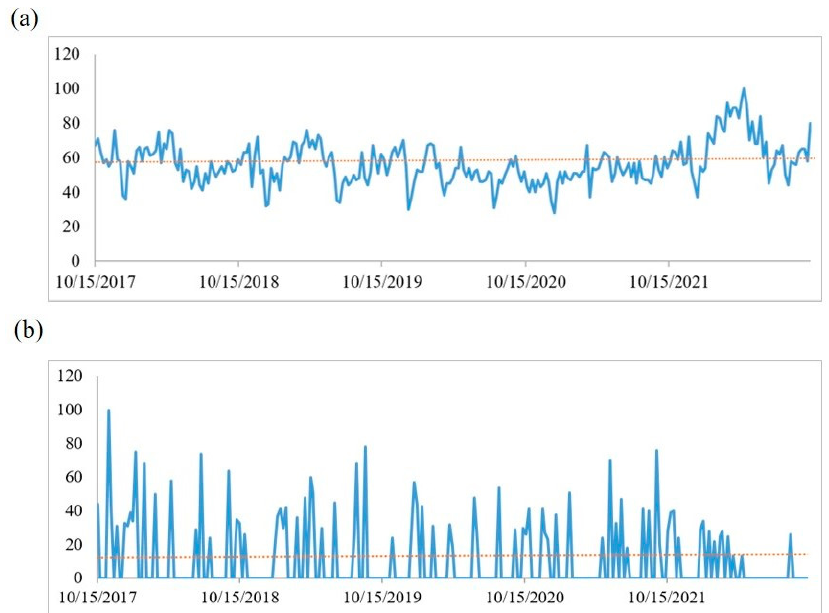
Figure 8. Time series of solar photovoltaic count in ( a ) worldwide and ( b ) Taiwan.